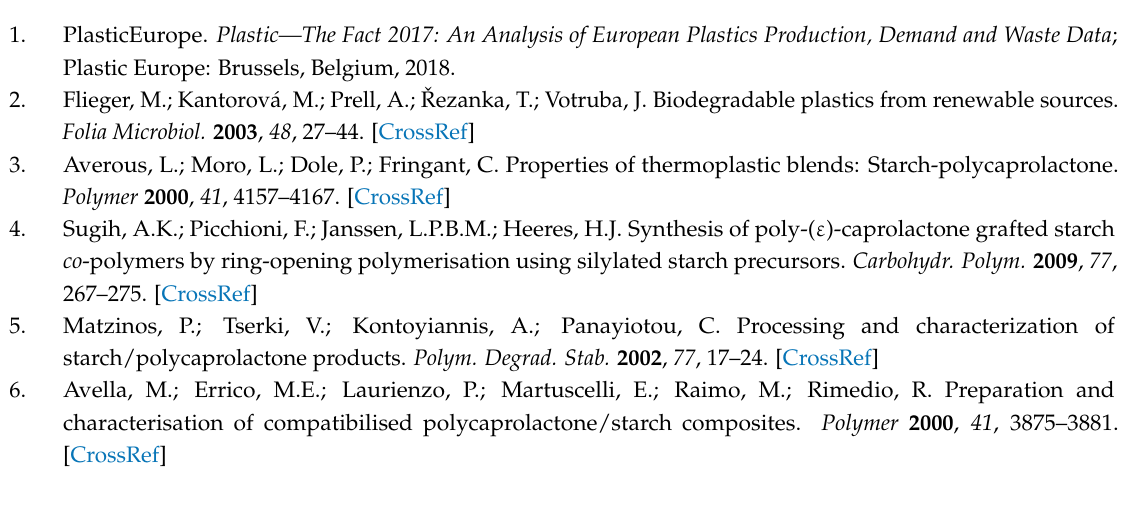
s1, Table S1: Overview of experiments in the melt, Figure S1: Blends morphology as function of the PCL- g -GMA intake; Table S2: Selective solvent extraction data, Table S3: Thermal properties of the prepared